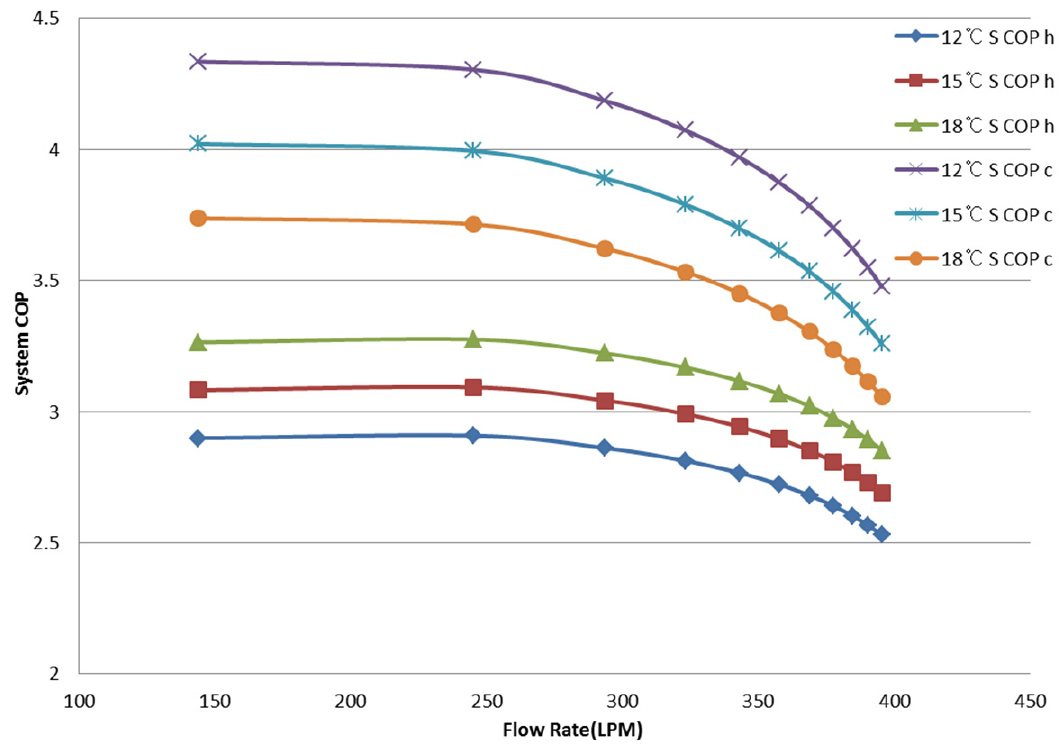
Figure 8. System Cooling and Heating COP variation to Groundwater Temperature.